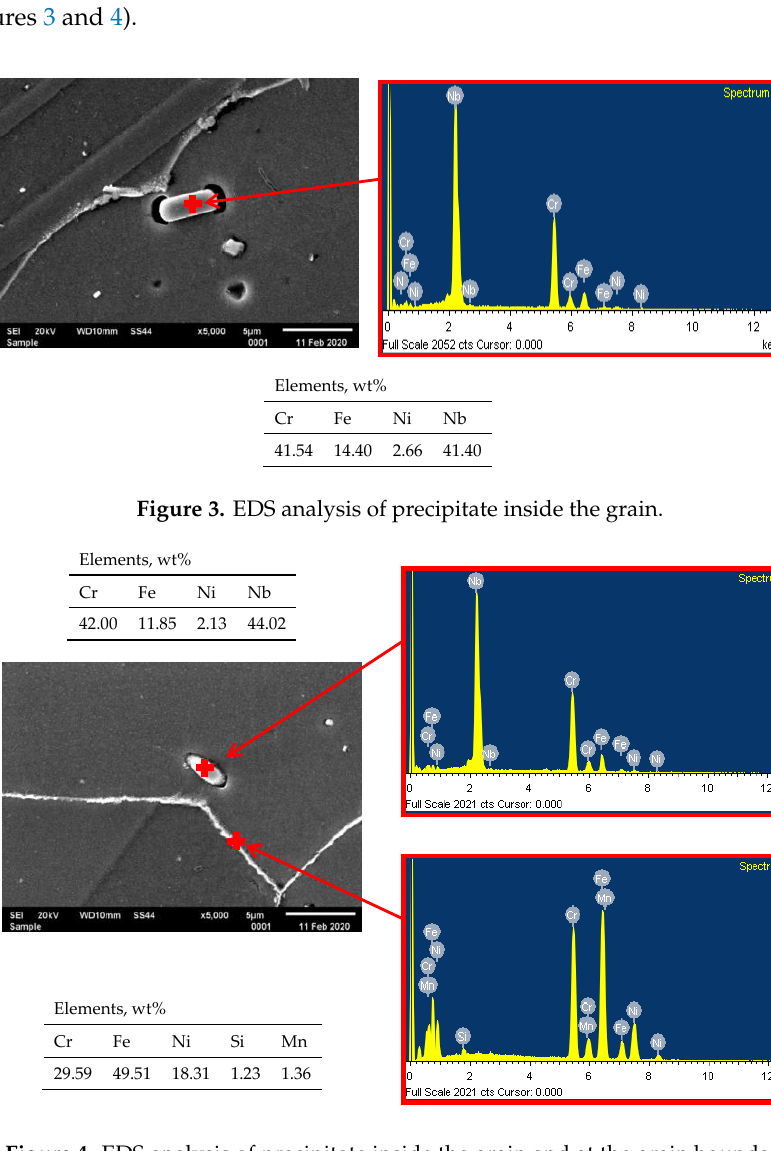
Figure 2. Primary Z-phase precipitate ( a ), resolved diffraction ( b ), EDS analysis ( c ); TEM.